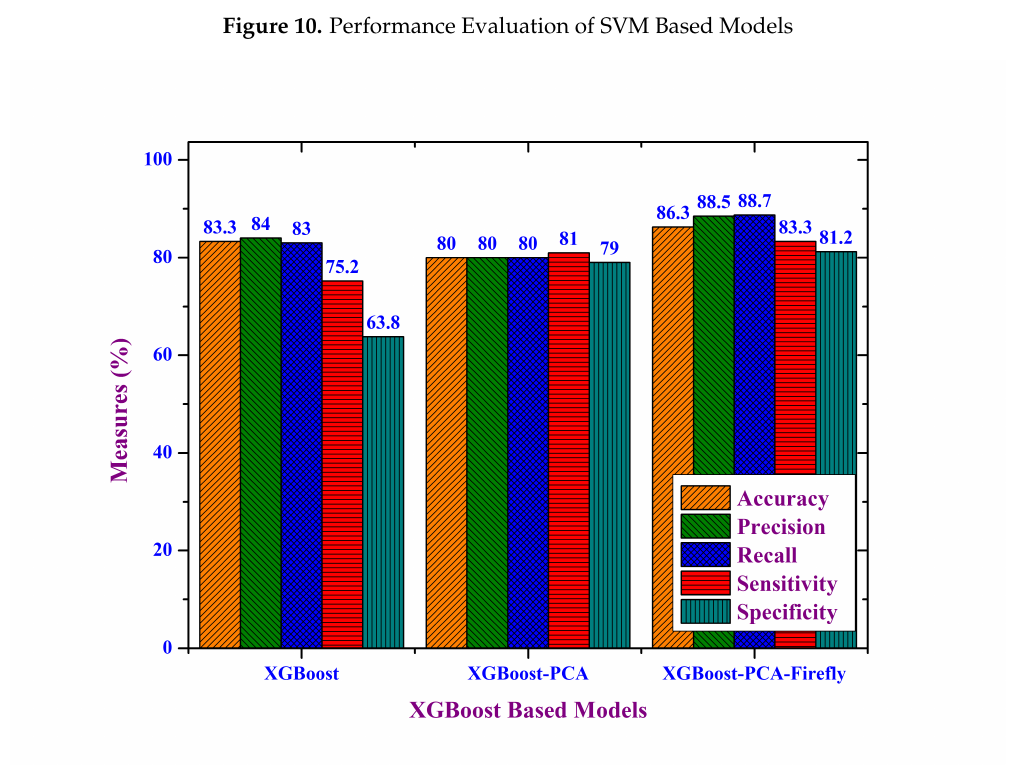
Figure 11. Performance Evaluation of XGBoost Based